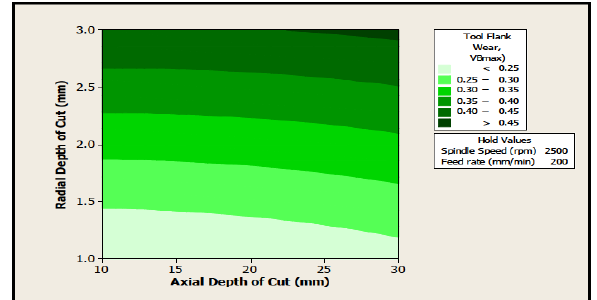
Figure 8: Surface plot of tool wear vs. radial depth of cut and axial depth of cut.